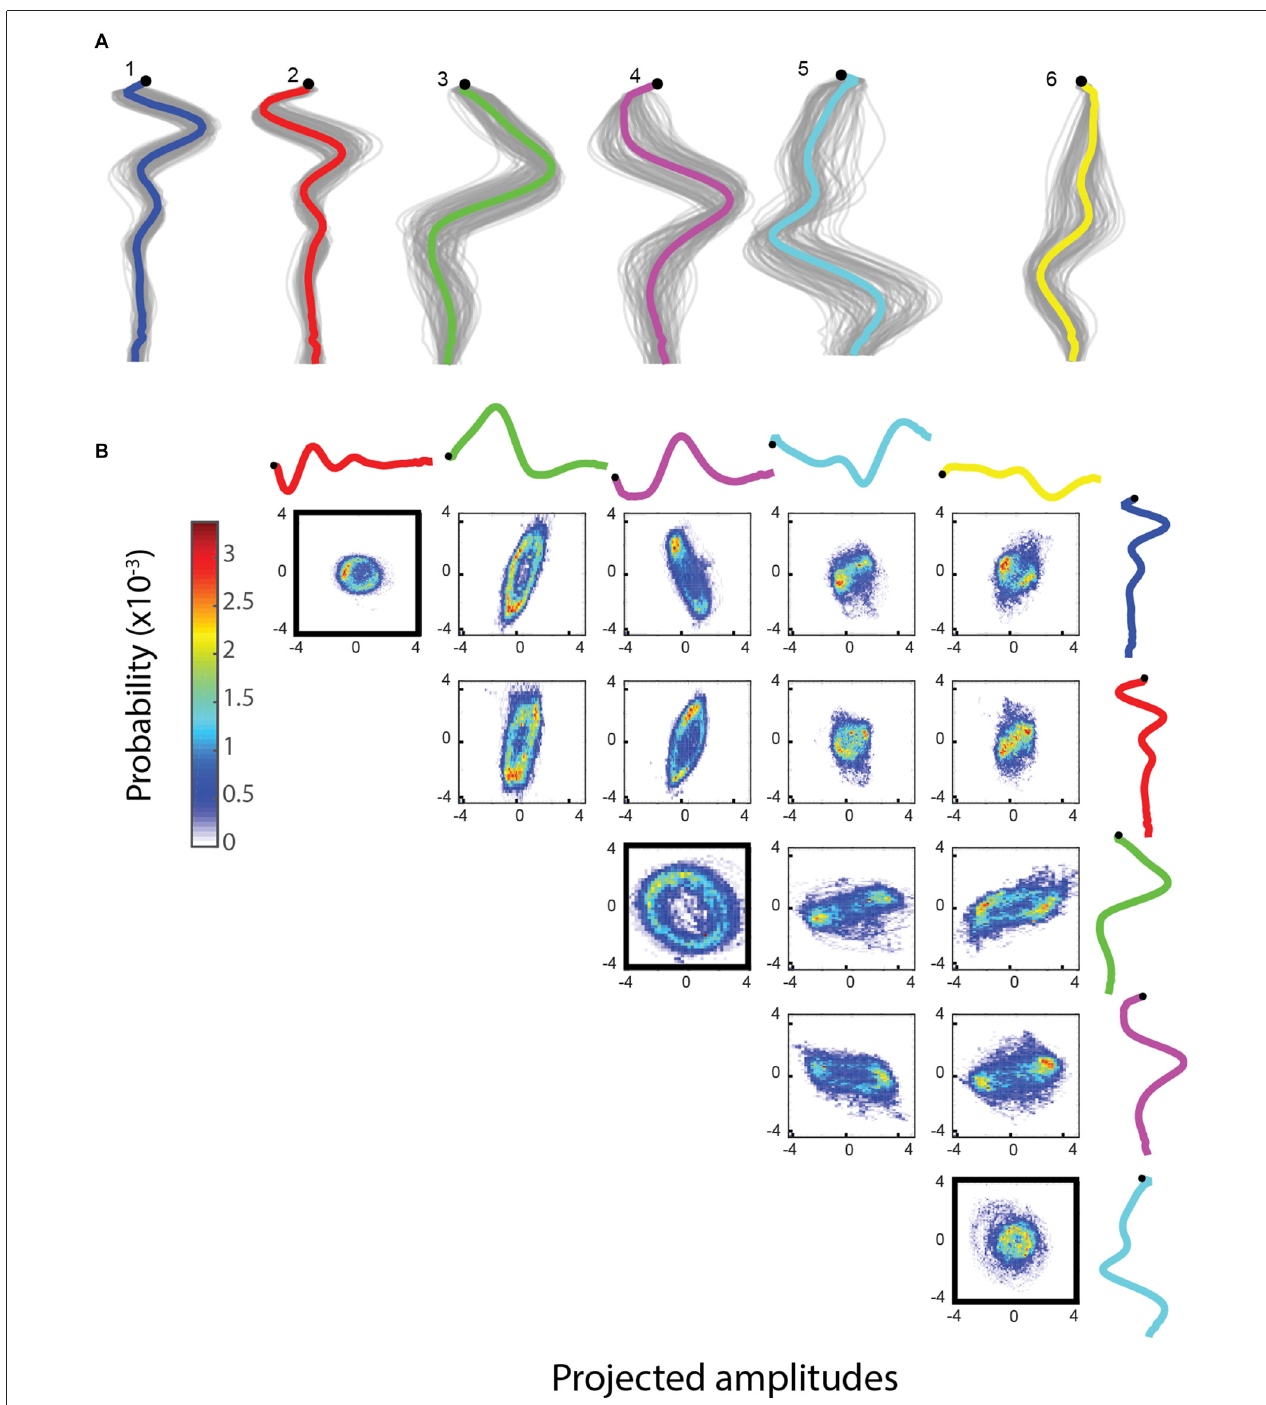
FIGURE 6 | (A) jPCA is run with 12 components (top six shown here). The graph shows an x - y coordinate representation of the modes with the resampled basis shapes in gray. (B) Bivariate histograms for the amplitudes of basis shapes (wild type worm, 15 min, frame rate: 30 Hz). Basis shapes 1, 2, 3, 4, 5 and 6 all form rings, suggesting an oscillatory behavior between them and independent sinusoidal waves in the corresponding parts of the body.